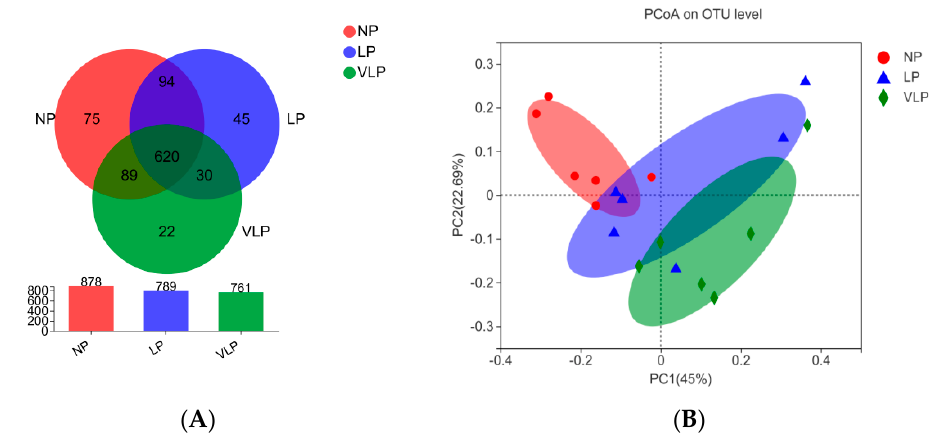
Figure 1. ( A ) Effects of different protein diets on colon microflora OTU of finishing pigs. ( B ) Principal coordinates analysis (PCoA) of microbial composition in the colon of growing pigs (based on the bary_curtis distance). The individual pig was regarded as the experimental unit ( n = 6). NP, normal protein; LP, low protein; VLP, very low protein.